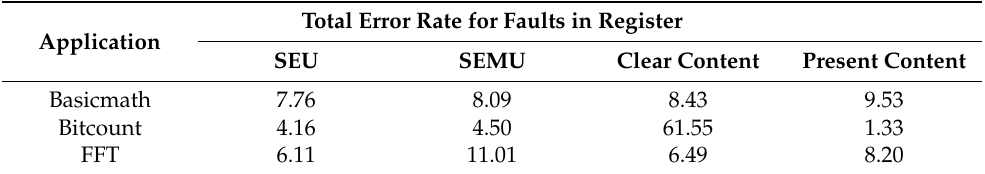
Table 2. Error rate classified per application and fault model in register.